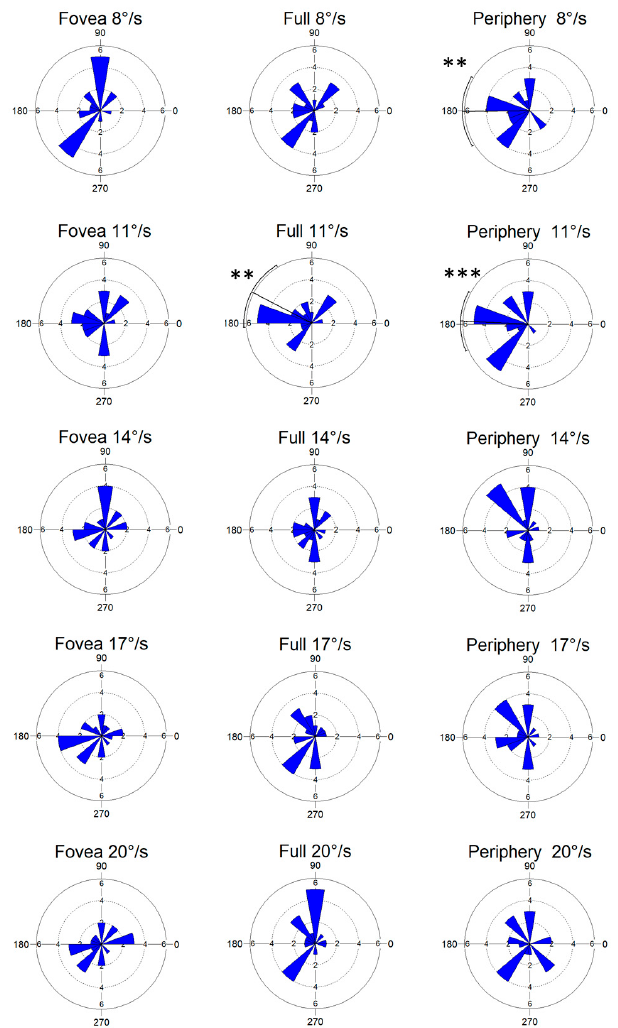
Figure 4. Distributions of preferred directions of oscillation for optic flow stimuli at different speeds. Rose diagrams show the frequency distribution of the mean vectors of all trials computed for each stimulus in each subject. The diagram plots lines on each of the 360° of a compass distribution, with the length proportional to the number of values in that direction. The solid line crossing each diagram indicates the mean vector when significant, whereas the curved line outside the circle indicates circular SD. The bars are 20° wide. Asterisks indicate significant values with non-uniform distribution (Rayleigh test of uniformity).